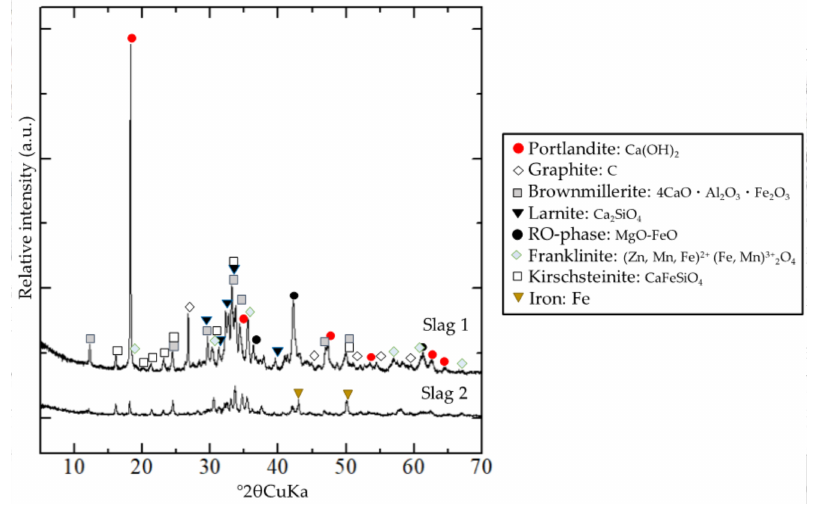
Figure 3. XRD profiles of steel slag 1 and slag 2 prior to mixing with dredged